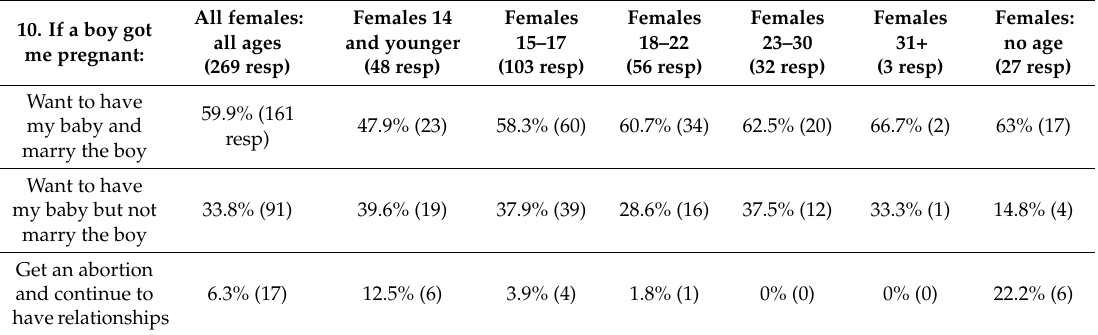
Table 16. Pregnancy Options—All